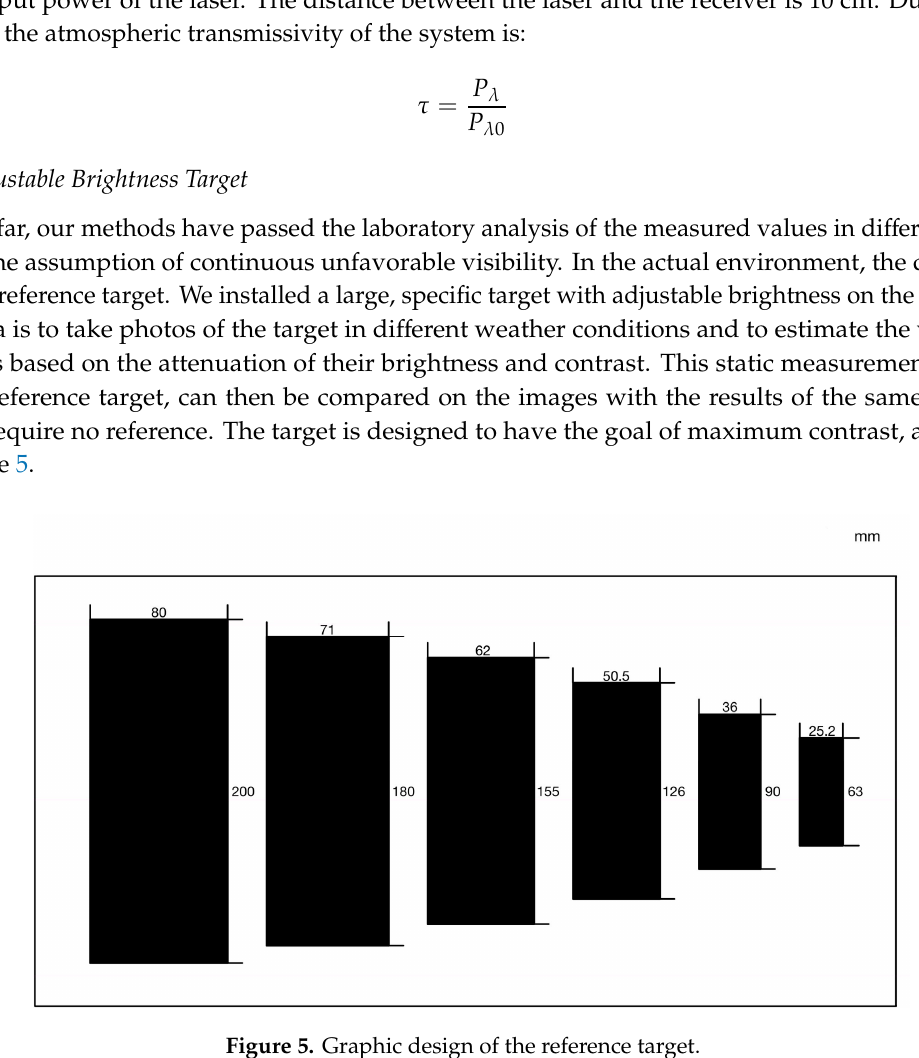
Figure 5. Graphic design of the reference target.